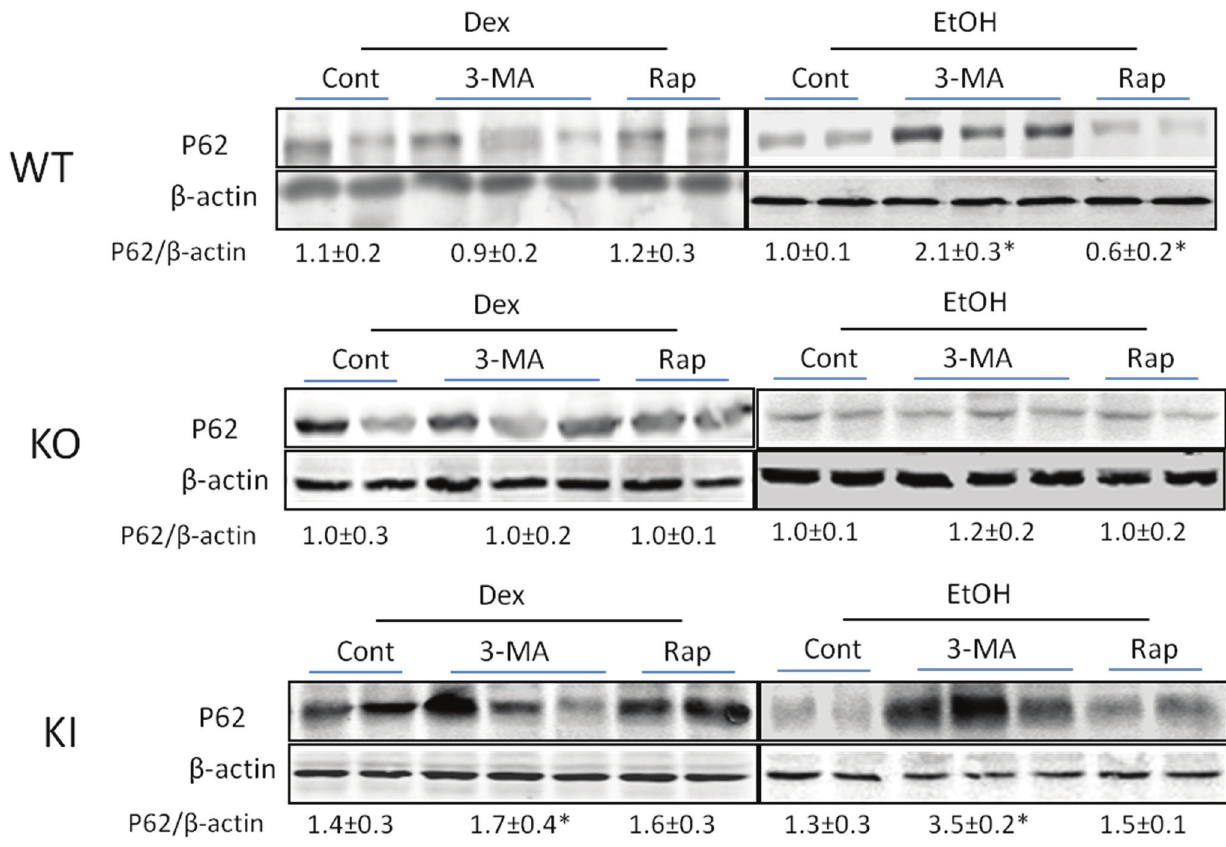
Figure 7. Effect of chronic ethanol or ethanol plus 3-MA or rapamycin on levels of p62. p62 levels in WT, KO and KI mice fed with alcohol or dextrose with or without 3-MA or rapamycin administration were evaluated by immunoblots. *, p < 0.05 compared with ethanol alone-fed